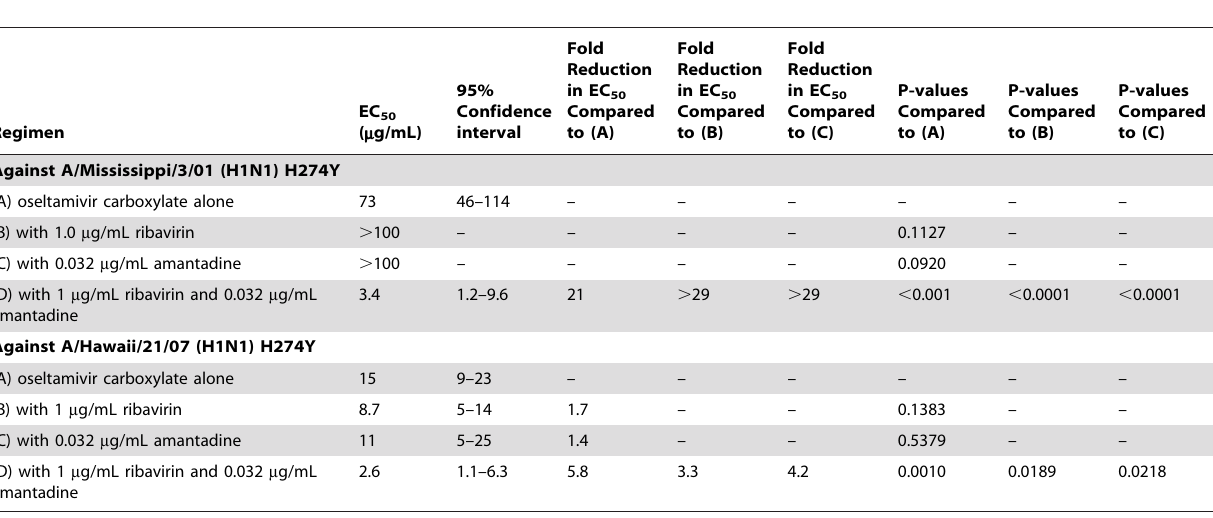
Table 3. The 50% effective concentration (EC 50 ) of oseltamivir carboxylate as single agents and in double and triple combinations against seasonal oseltamivir-resistant viruses as determined by Neutral Red assay.